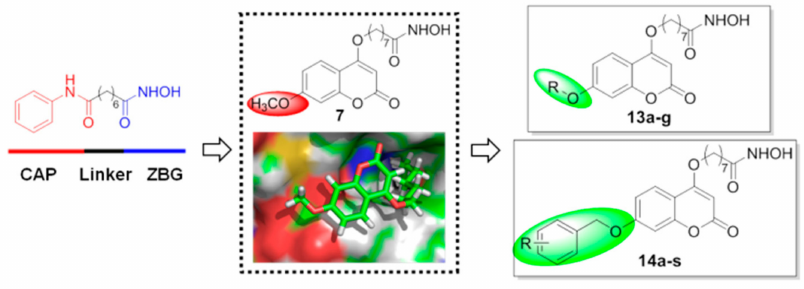
Figure 2. Design strategy and general structures of the target